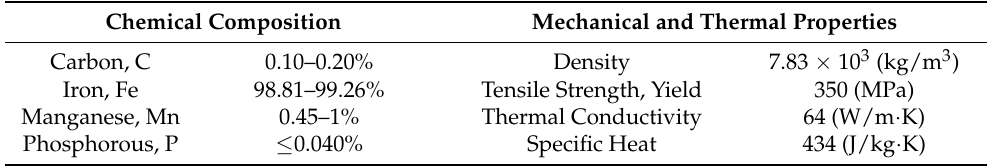
Table 1. HA 250 mild steel mechanical and thermal properties [41].